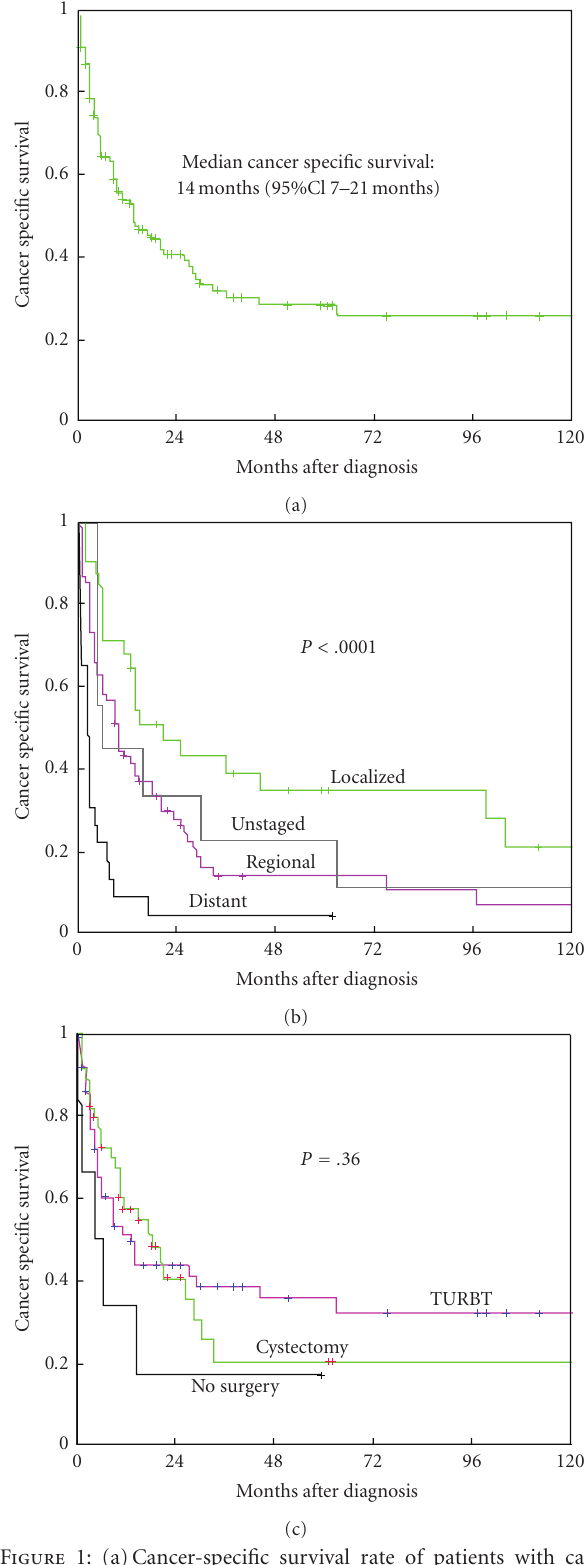
Figure 1: (a)Cancer-specific survival rate of patients with car- cinosarcoma of the bladder. (b) Cancer-specific survival rate according to SEER stage. (c) Cancer-specific survival rate according to status of cystectomy (TURBT: transurethral resection for bladder